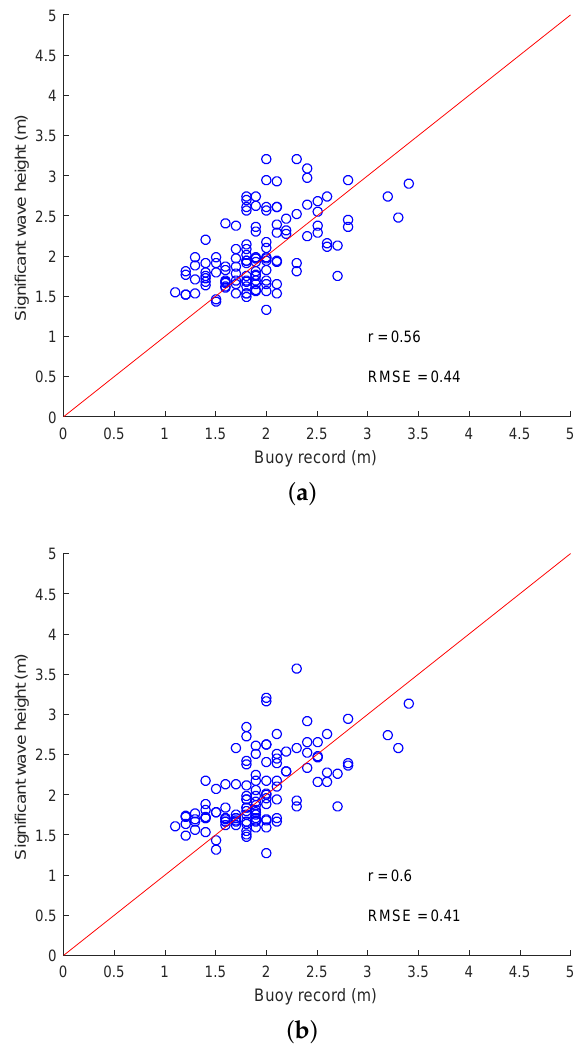
Figure 7. The scatter plots of the significant wave height between the buoy record and the radar- derived. ( a ) The scatter plot of the wave height ignoring the influence of the surface current; ( b ) The scatter plot of the wave height considering the influence of the surface